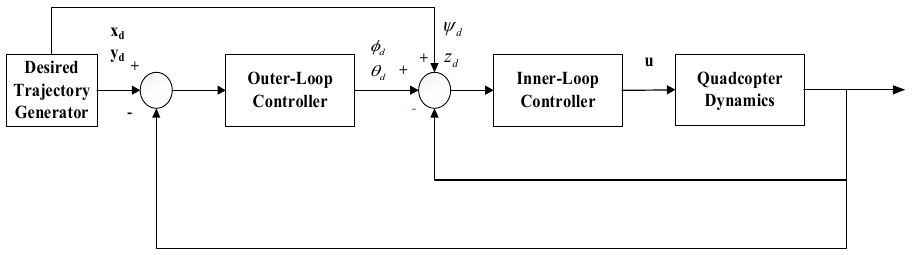
Figure 3. Structure of the quadcopter tracking controller. Figure 3 . Structure of the quadcopter tracking controller . The controller used in the open-source flight controller (PX4) is the PID The controller used in the open-source flight controller (PX4) is the PID controller.